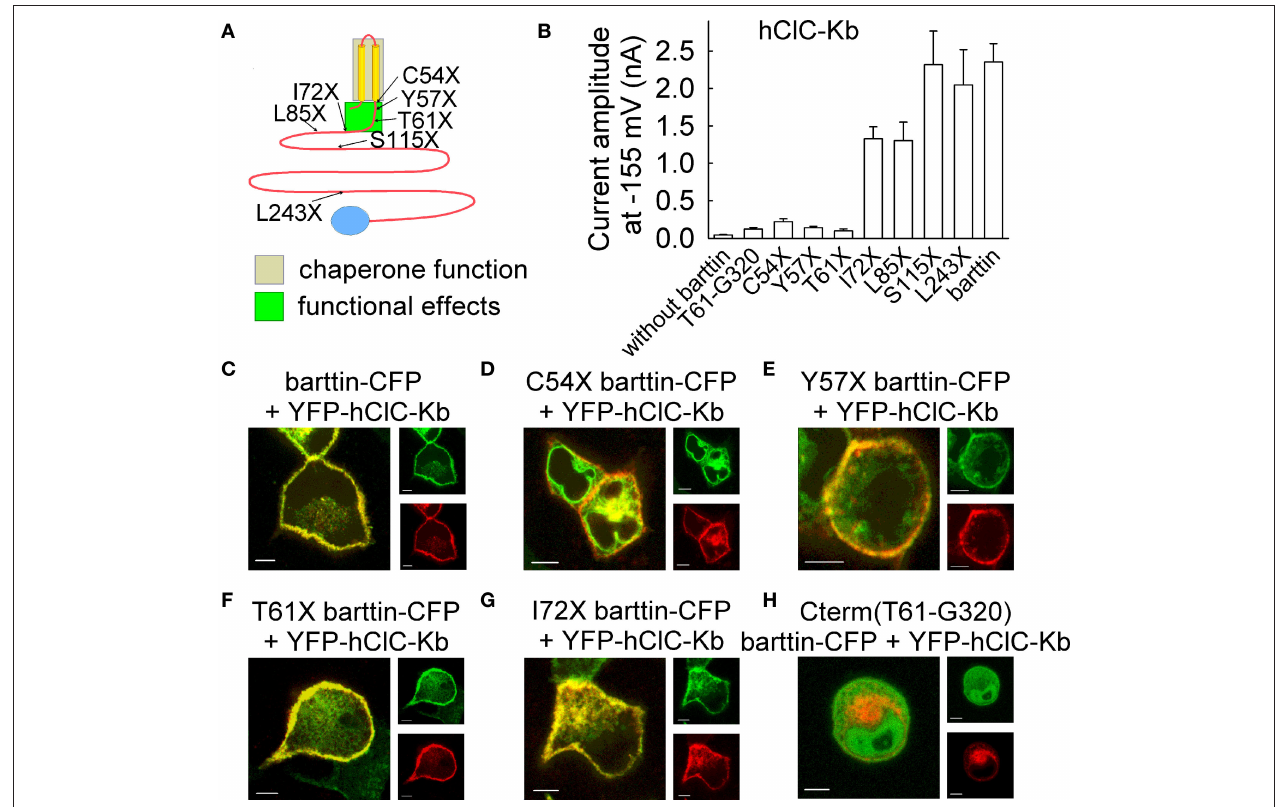
Figure 4 | Truncation mutants of barttin affect subcellular distribution and functional properties of hClC-Kb channels. (A) Localization of tested carboxy- terminal truncations that result in functional deficits of barttin. Chaperone function of barttin is assigned to the two transmembrane domains. (B) Mean isochronal current amplitudes of hClC-Kb determined 2 ms after a voltage step to − 155 mV on